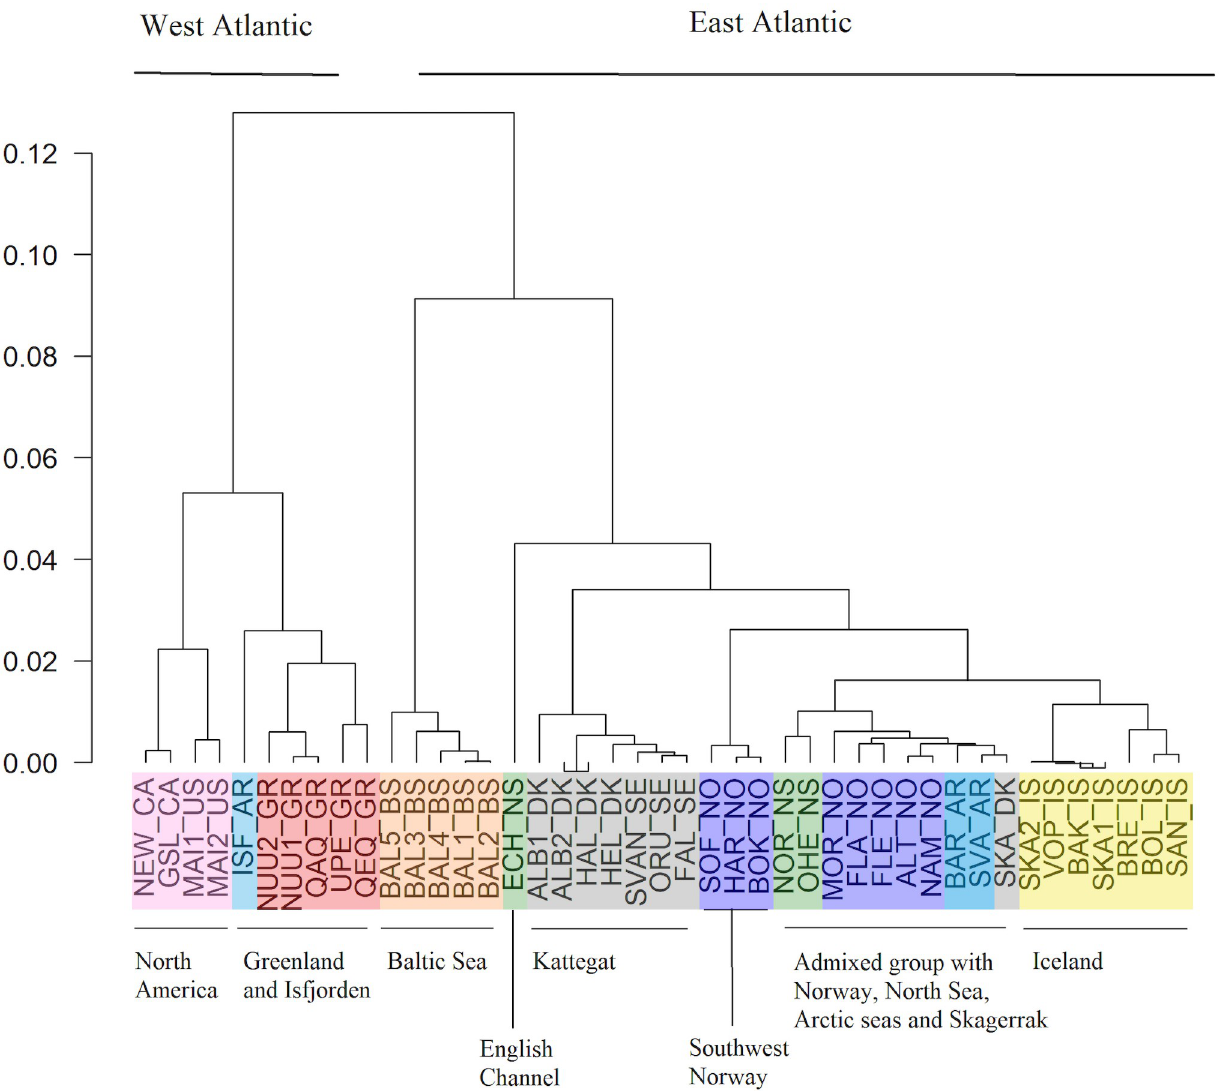
Fig 2. Dendrogram of population pairwise F ST estimated in lumpfish ( Cyclopterus lumpus ) based on a targeted dataset with 139 SNPs. Sample codes and colors indicate geographic regions as described in Table 1.